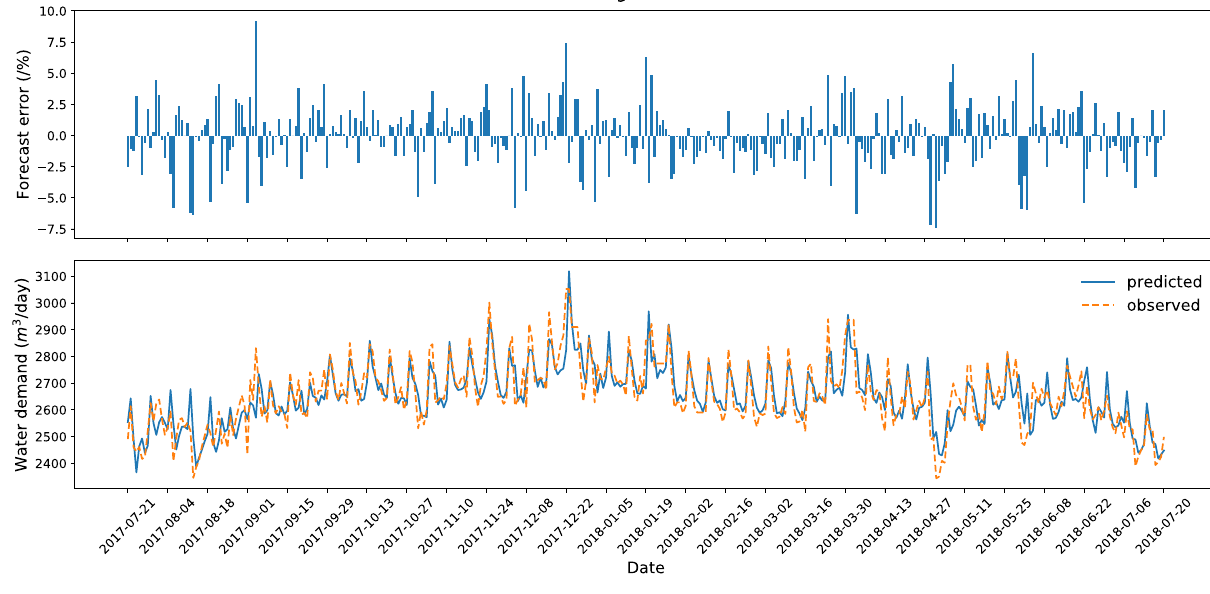
Figure 6. Research results for the worst variant of forecasting—training dataset (dataset no. 7).